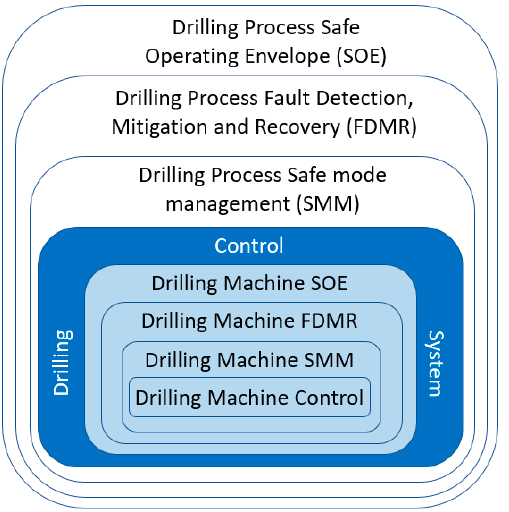
Figure 3. Schematic representation of the different layers of protection at the drilling process level and at the drilling machine level.